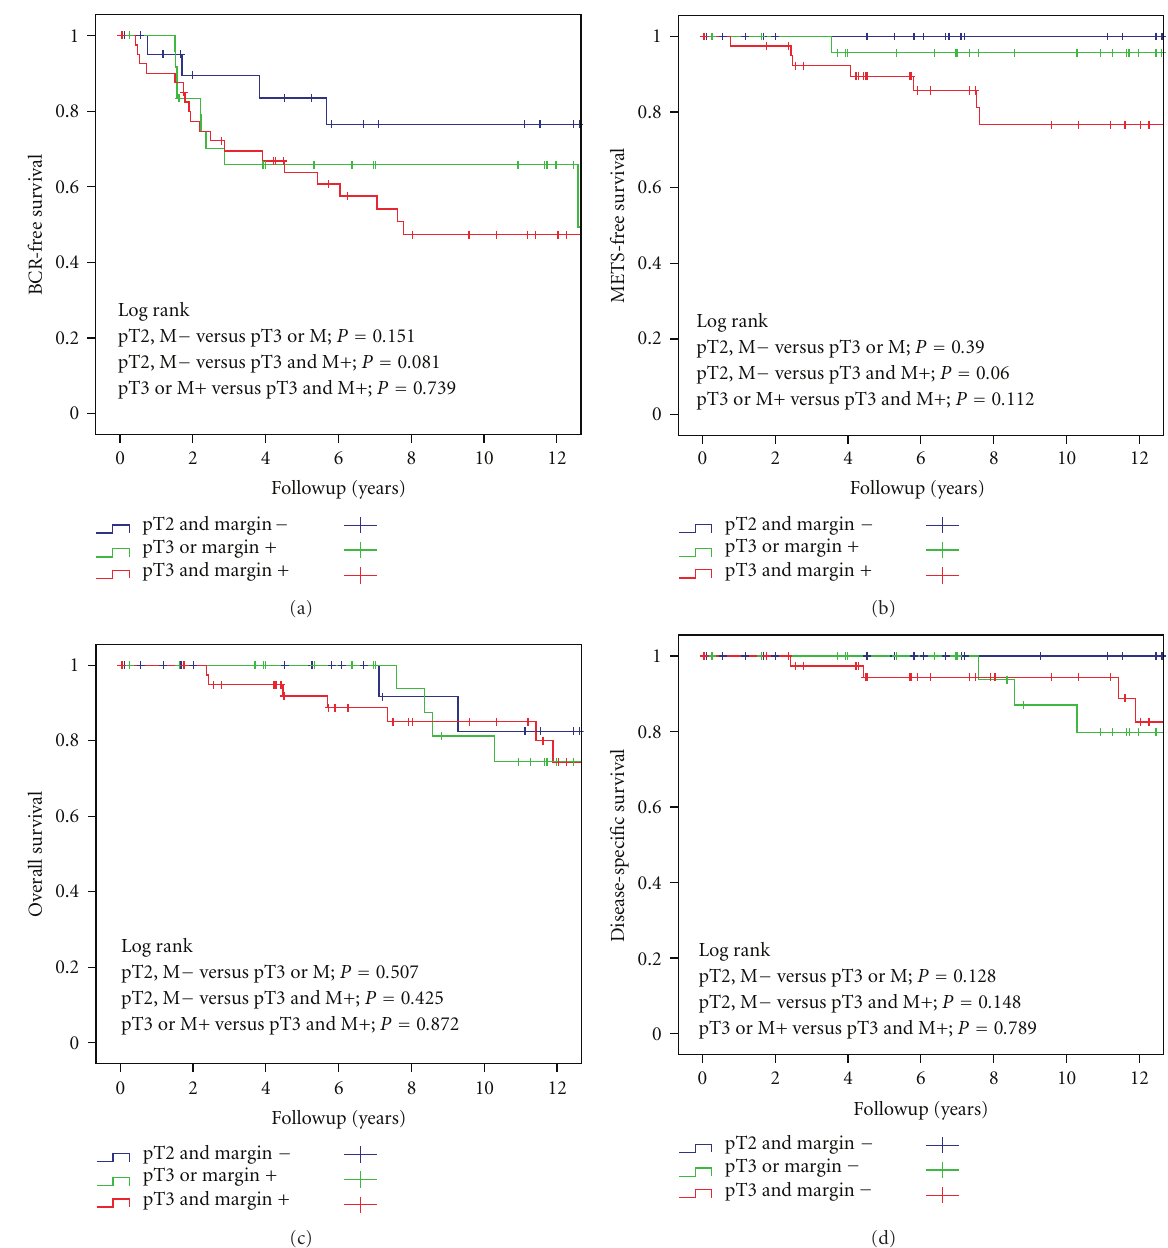
Figure 1: Kaplan-Meier estimates of BCR (a), distant recurrence (b), overall survival (c), and disease-specific survival (d) according to stage and surgical margin